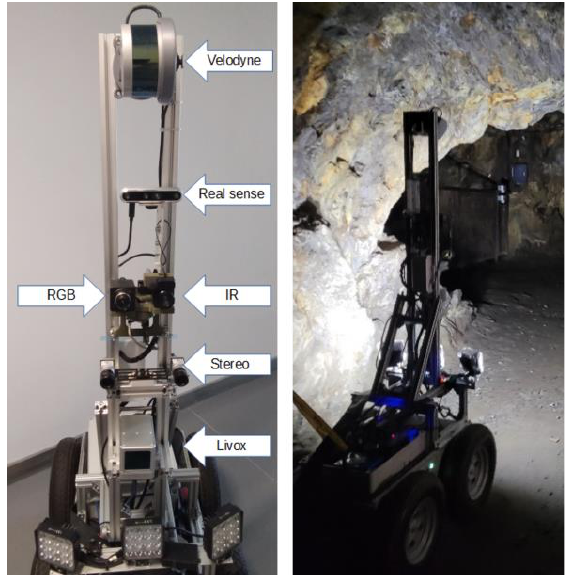
Figure 1: Sensors of the mobile robot (left) and the robot during a survey in an underground mine (right).